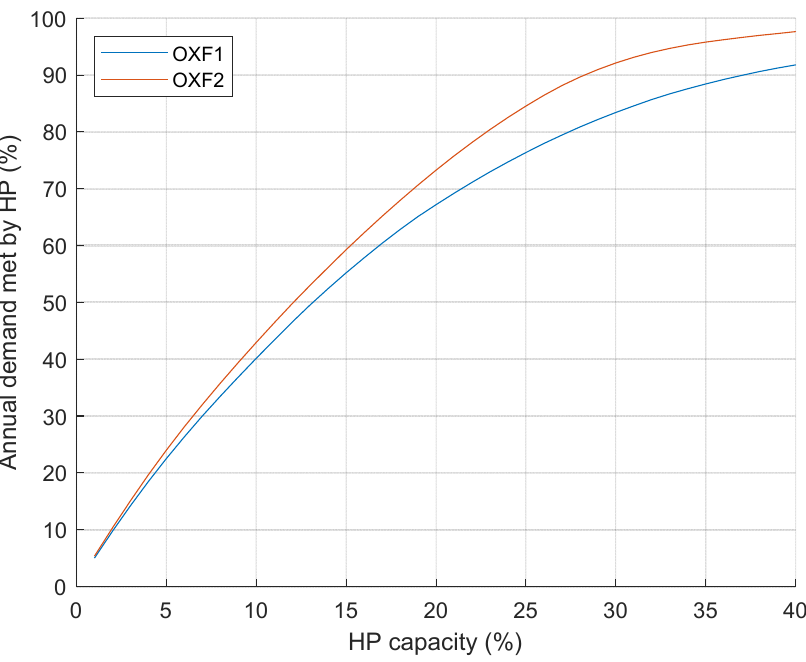
Figure 6. Relationship between heat pump capacity and proportion of annual demand met by heat pump, OXF1 and OXF2 (CH only). Table 2. Proportion of heat demand met by heat pump component of various sizes.